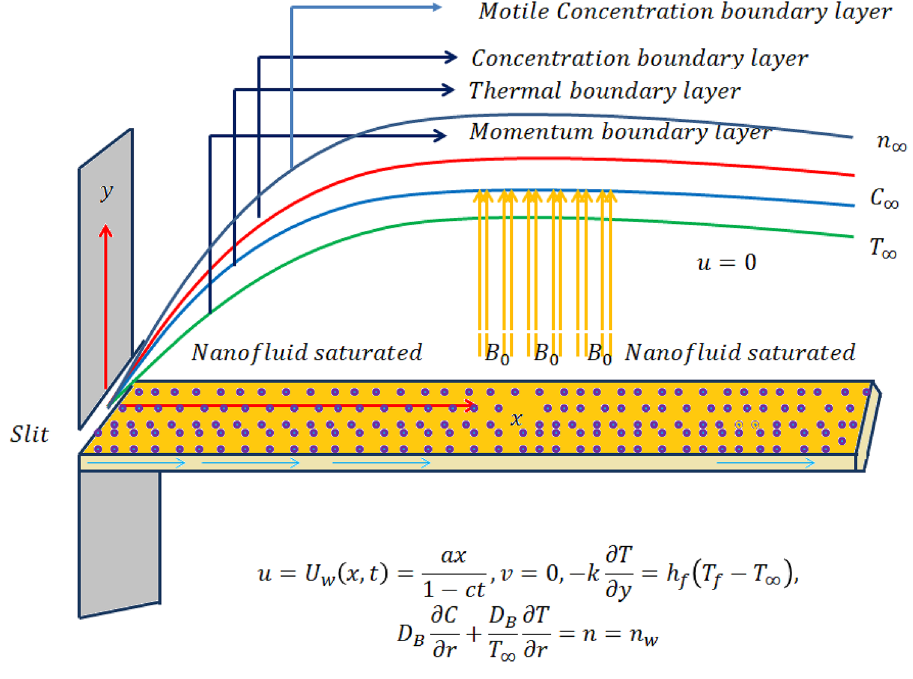
Figure 1. Schematic sketch of the physical